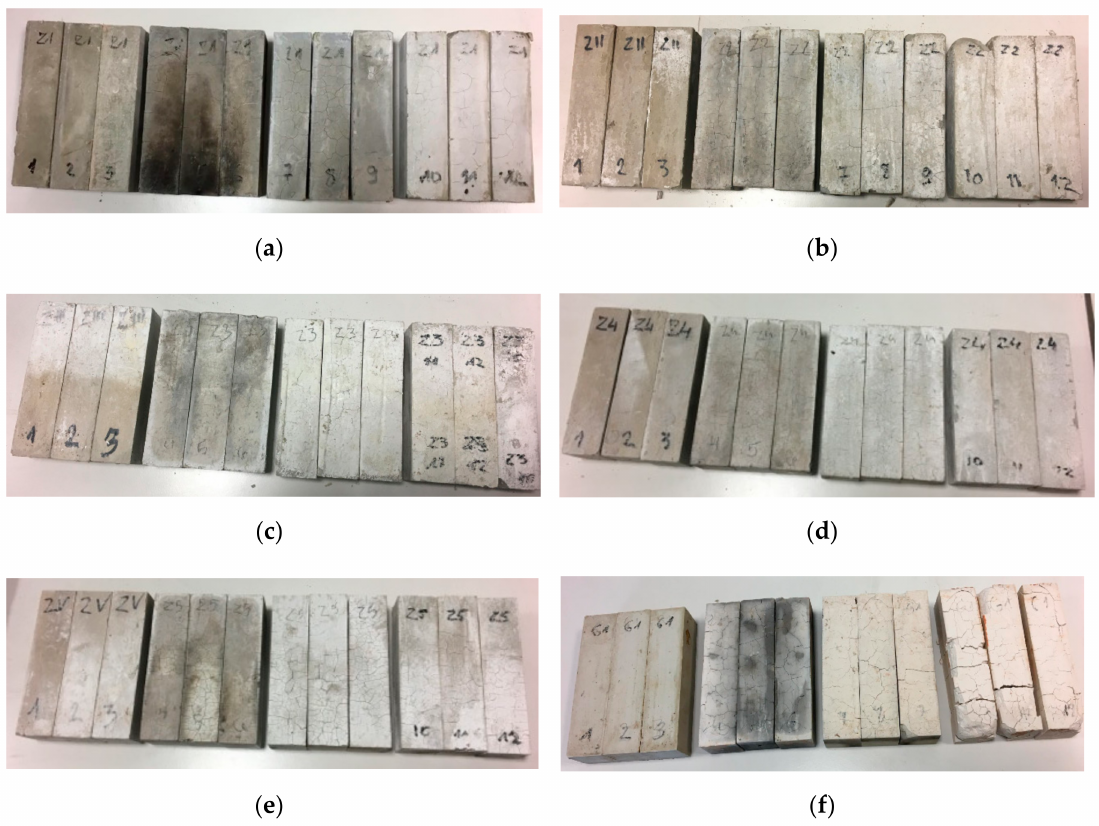
Figure 3. Grouped specimens. ( a ) Z1 specimens; ( b ) Z2 specimens; ( c ) Z3 specimens; ( d ) Z4 specimens; ( e ) Z5 specimens; ( f ) G1 specimens.